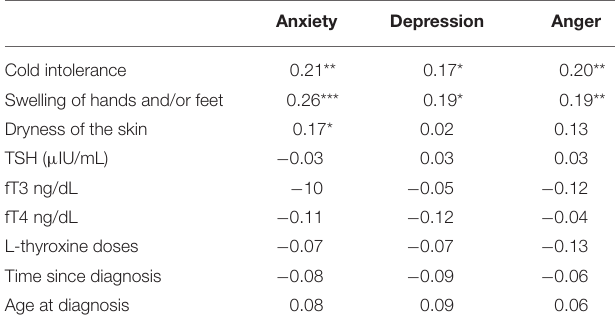
TABLE 2 | Partial correlations between the ED (depressive symptoms, anxiety, anger) and clinical variables (controlled by sociodemographic variables).